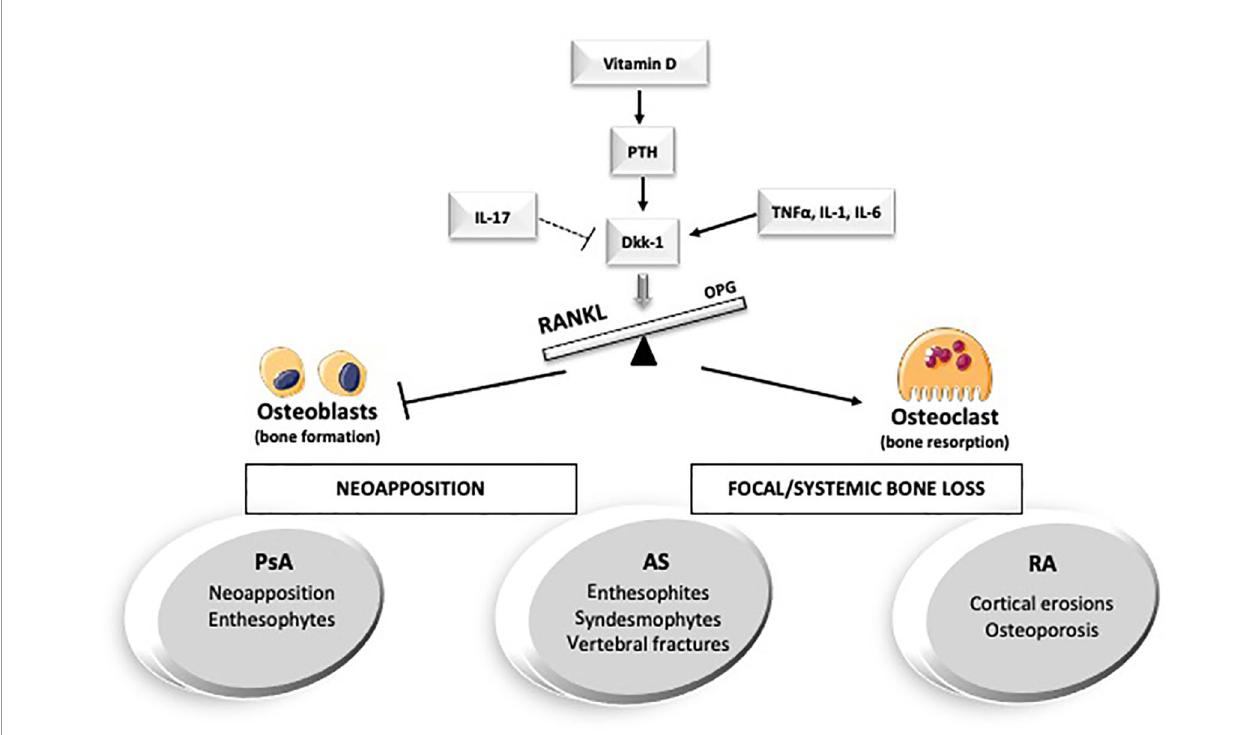
FIGURE 1 | Hormones and cytokines involved in bone metabolism in the main arthritic disorders. AS, anskylosing spondilits; Dkk-1, Dickopf-1; IL-, interleukin-; PsA, Psoriatic Arthritis; PTH, parathyroid hormone; RA, Rheumatoid Arthritis; TNFalfa, Tumor necrosis factor